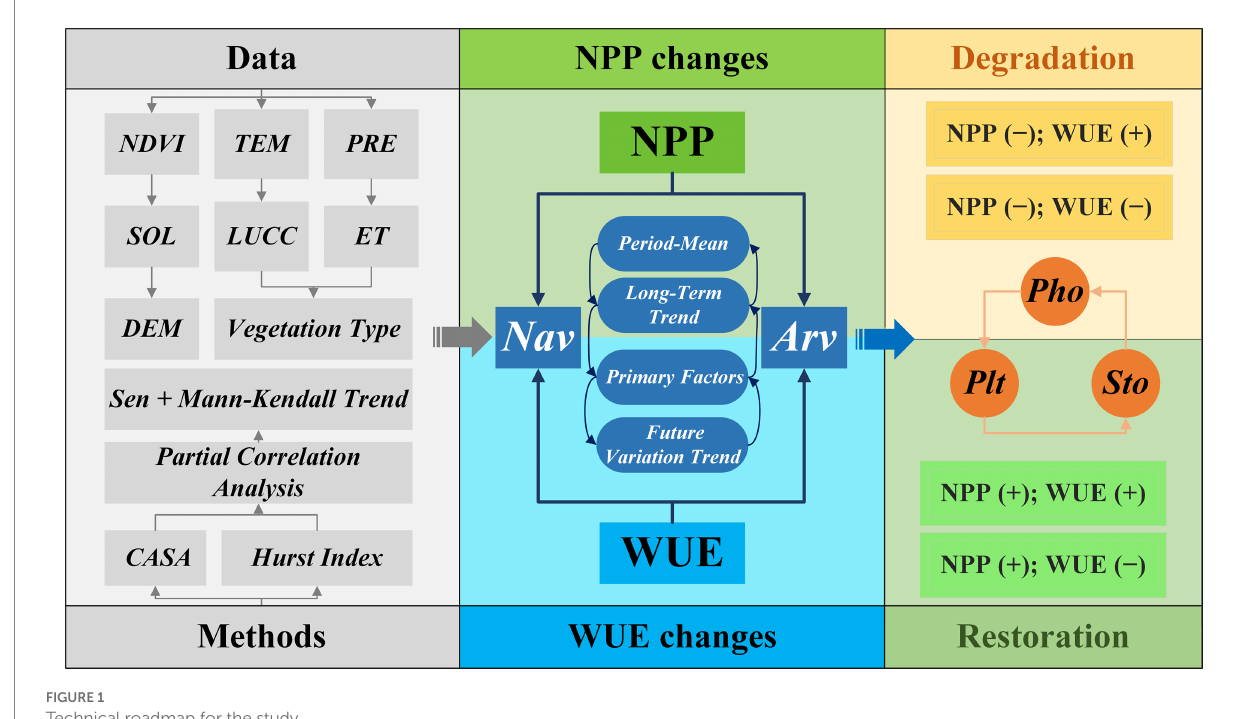
FIGURE 1 Technical roadmap for the study.